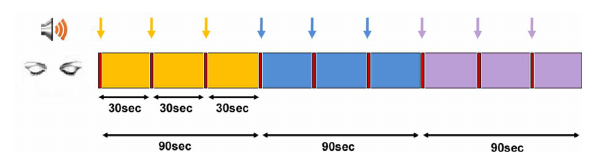
FIGURE 1 | Experimental protocol. The time and sequence of conditions in the two MEG sessions of “time” and “space.” Yellow—“There”/“Then,” blue—“Here”/“Now,” and purple—“Timelessness”/“Spacelessness” conditions. All epochs were initiated by an auditory cue (marked by arrows).